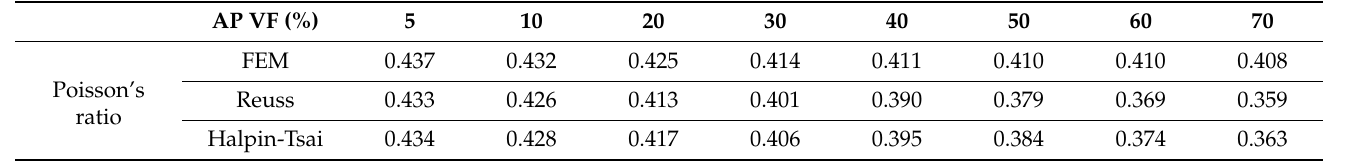
Table 6. FEM and numerical analysis predictions of Poisson’s ratios.